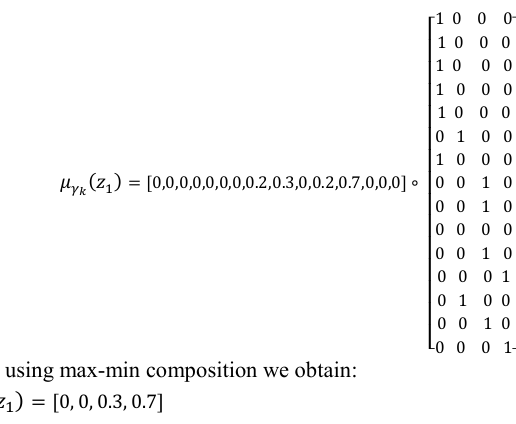
Table 4. Table used to